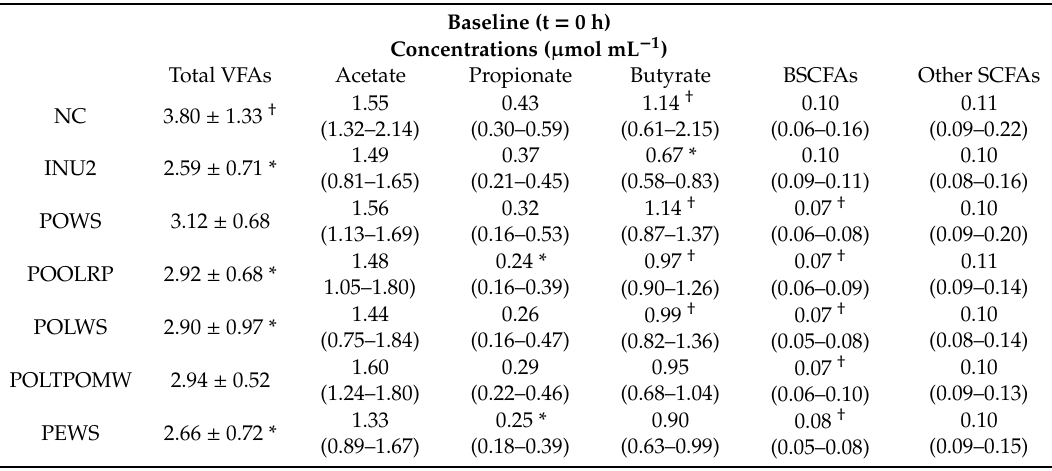
Figure 3. Differences (Δ) in concentrations (μmol mL − 1 ) of ( a ) branched SCFAs (BSFAs) and ( b ) other SCFAs after 8- h fermentation (ΔCt8 -0) and 24- h fermentation (ΔCt24 -0) compared to baseline. Values are expressed as mean and SD, where ΔCt8 -0 is defined as ‘Concentration t = 8 h minus Concentration t = 0 h’ and ΔCt24 - 0 is defined as ‘Concentration t = 24 h minus Concentration t = 0 h’ (for POLTPOMW and HEBS n = 4 - for CC2WS and CC505 n = 7);*: significant difference compared to NC ( p < 0.05) (Mann-Whitney test or t- test);†: significant differen ce compared to INU2 ( p < 0.05) (Mann-Whitney test or t-test). Table 4. Total volatile fatty acids (VFAs) and SCFAs concentrations ( μmol mL −1 of sample) at baseline and after 8-h and 24-h fermentation.